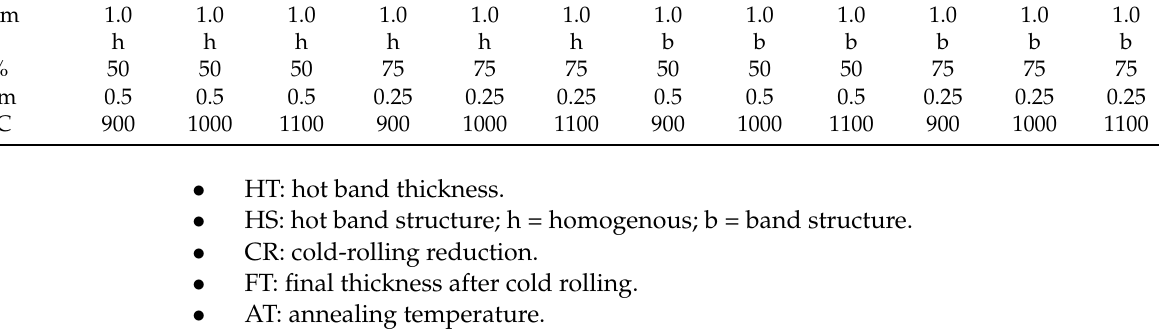
respect to the sample geometry. The A -parameter describes the mean angle of all orientations of the orientation distribution function between the magnetization vector and the closest easy axis of an orientation. In Table 4, the A -parameters in the RD, TD and averaged orientation are displayed. The averaged parameter is a mean value of all orientations between the RD and TD in 5 ◦ steps to account for hard magnetization axes in